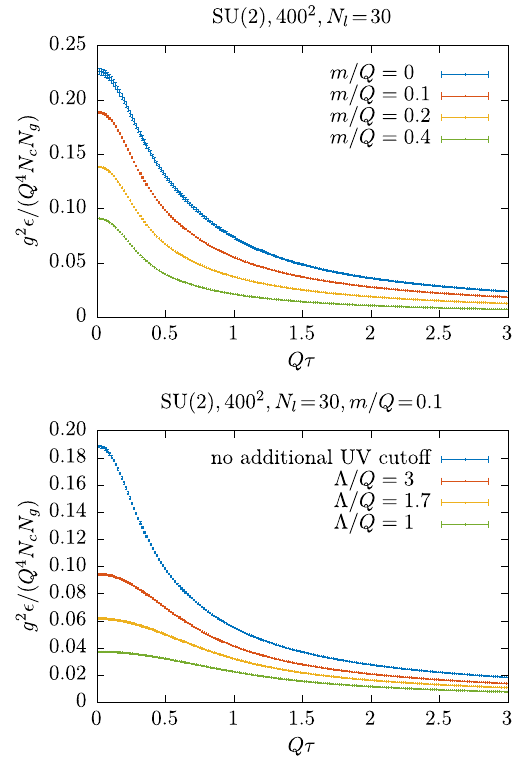
Fig. 5 Total energy density for different IR (top) and UV (bottom) cutoff parameters